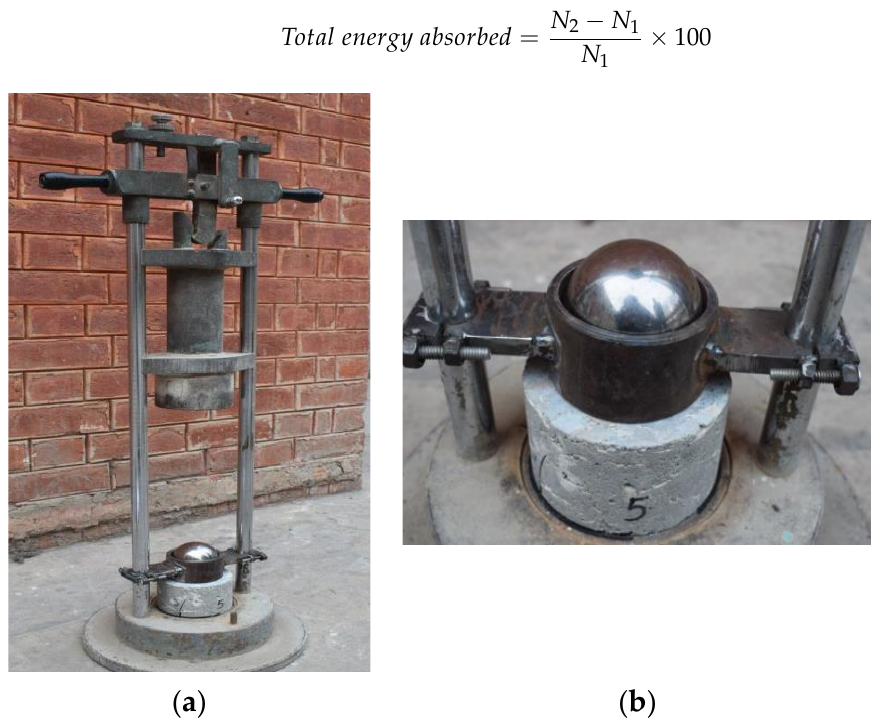
Figure 6. Impact test performance: ( a ) impact test setup, ( b ) placement of the specimen in the impact test apparatus.